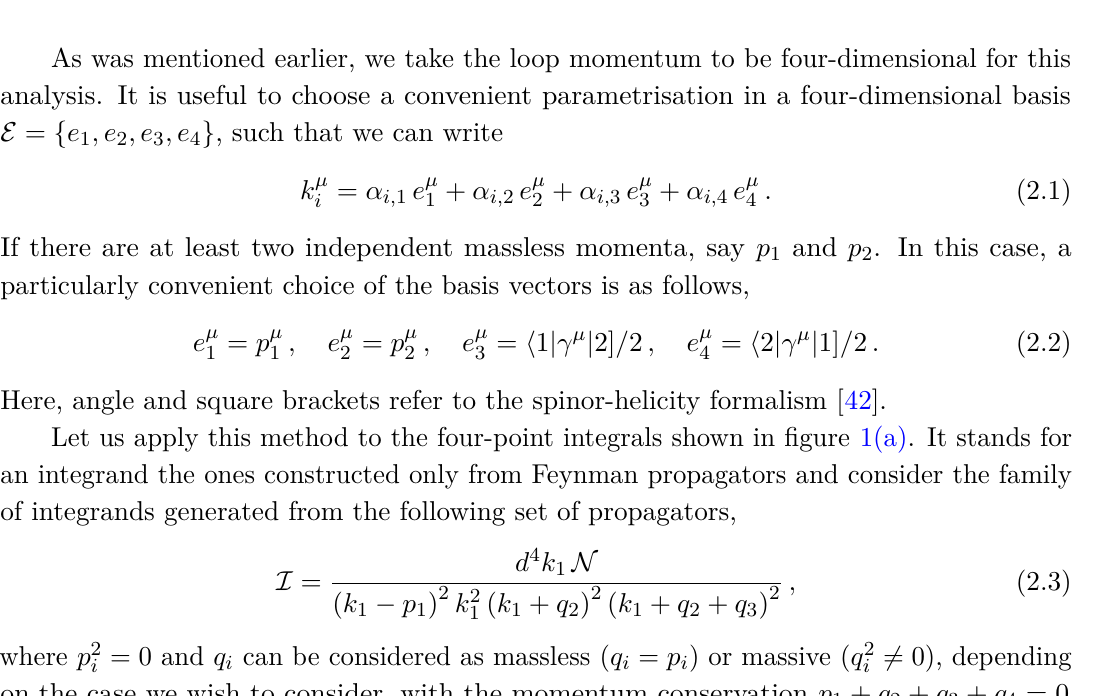
Figure 1 . d log basis for integrand family